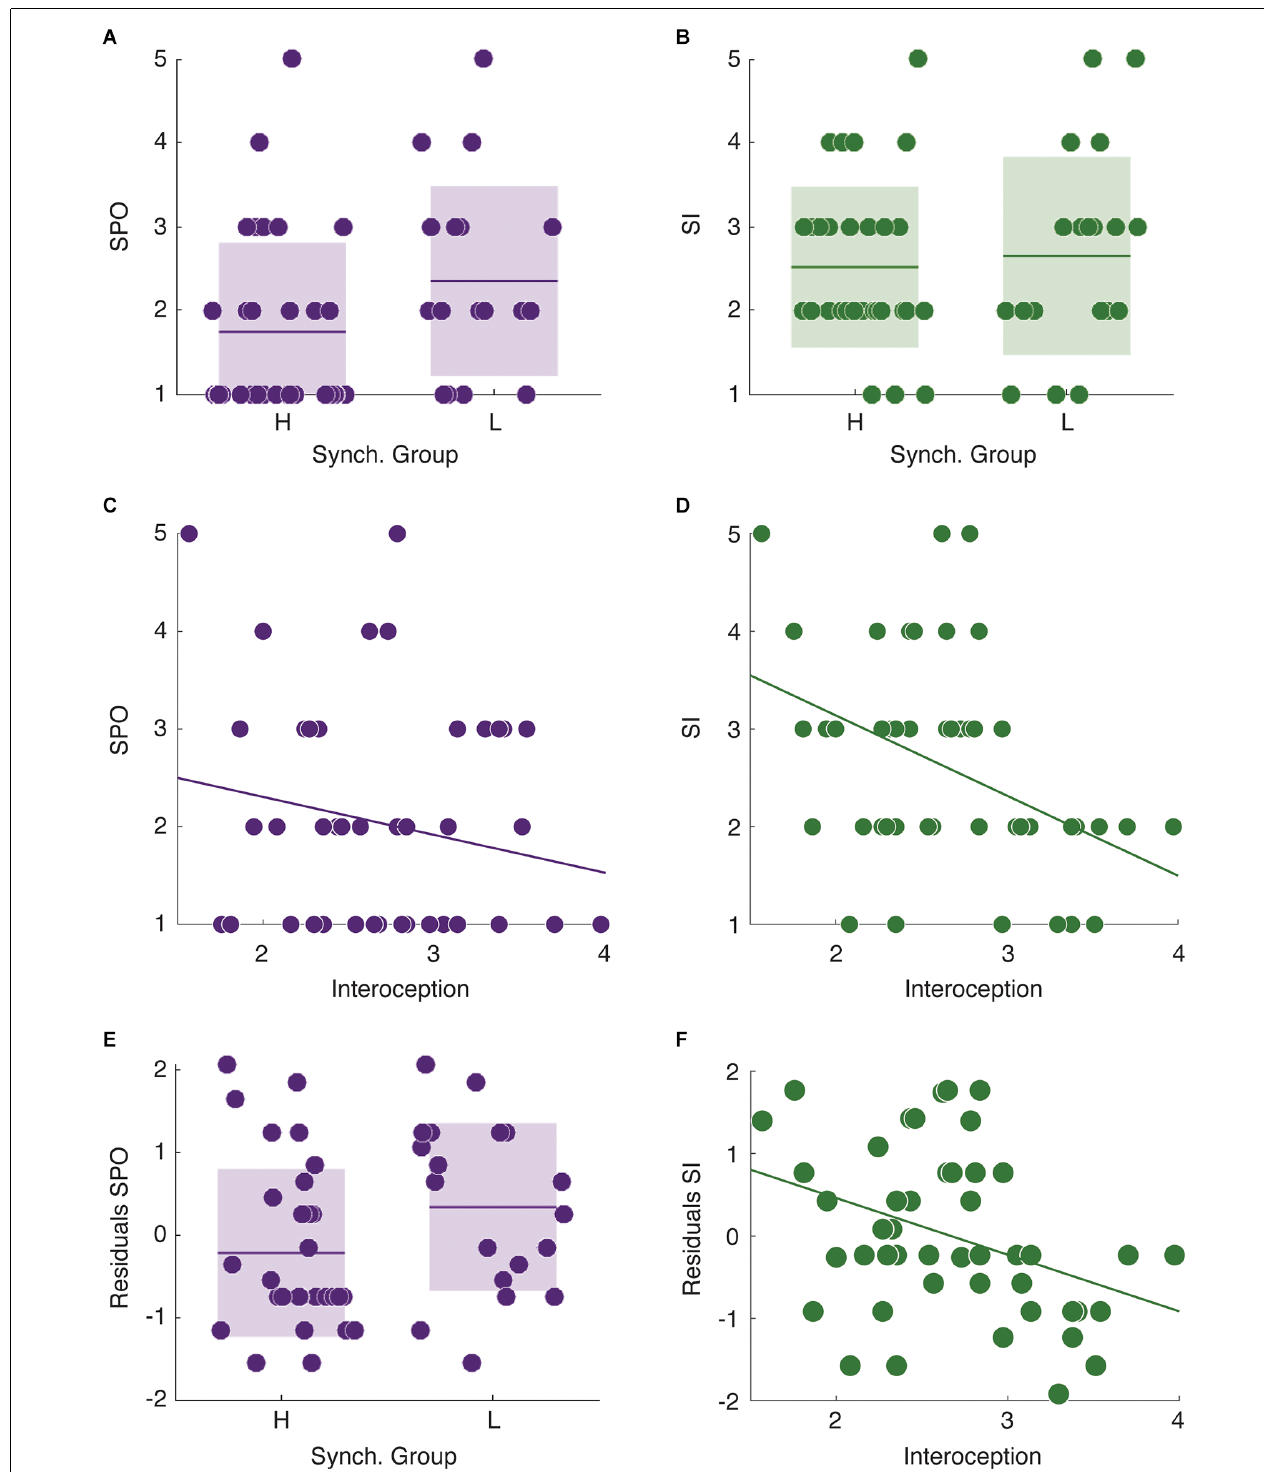
FIGURE 2 | Relationships between individual cognitive features and the different levels of self-reported stuttering severity. (A) Low synchronizers show higher SPO values than HS. (B) No significant difference between synchrony groups in SI. (C) Interoception does not correlate with SPO. (D) There is a significant negative correlation between interoception and SI. (E) The residuals of the linear regression using SPO as dependent variable and SI as independent still differentiate between high and low synchronizers. (F) The residuals of the linear regression using SI as a dependent variable and SPO as the independent correlate with the interoception measurements. * p <